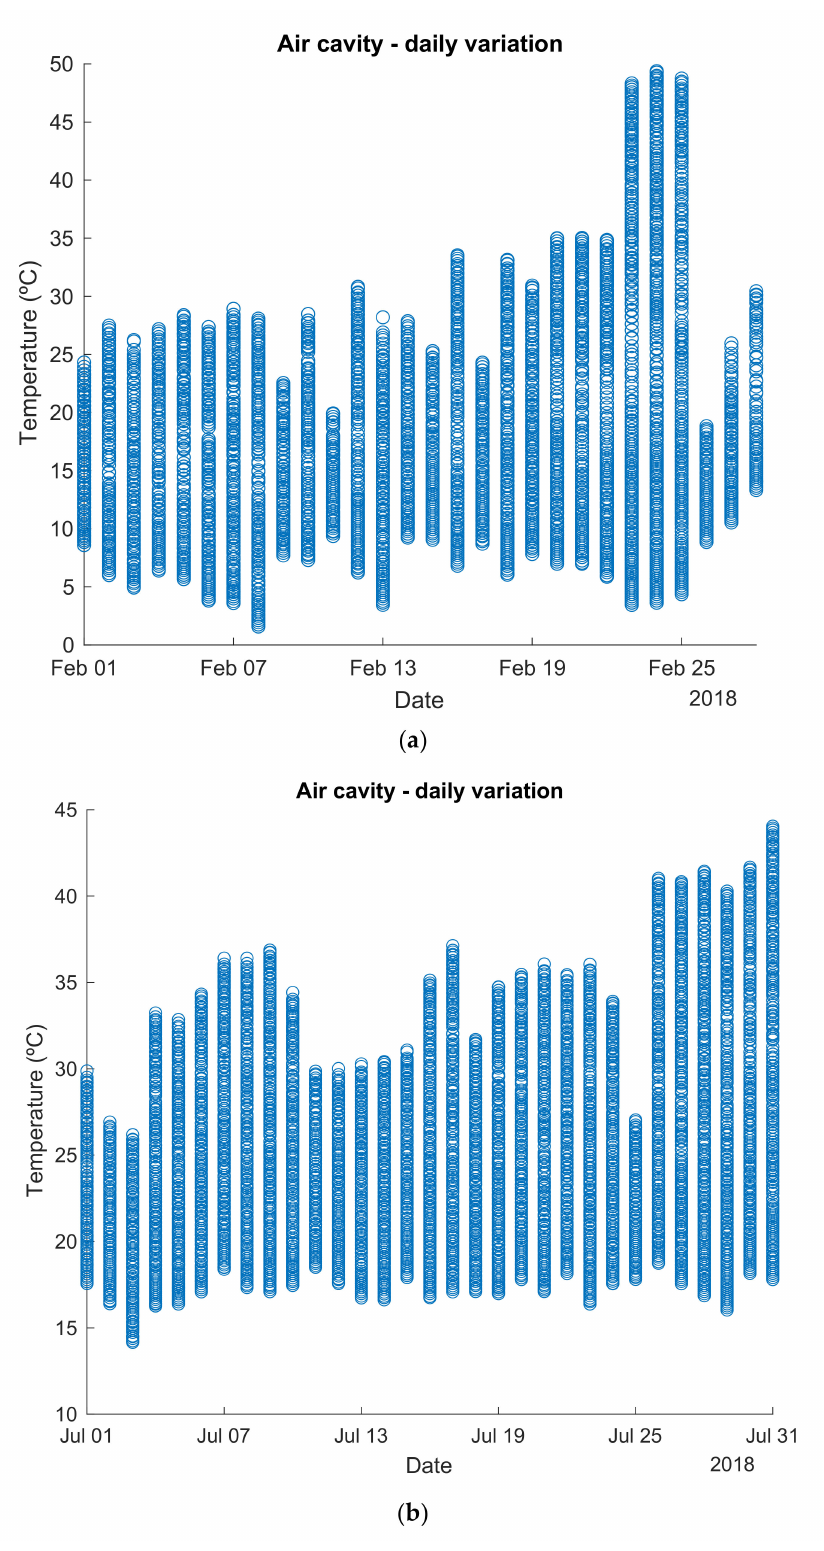
Figure A6. Detailed PV module temperature daily variation: ( a ) February/2018; ( b )